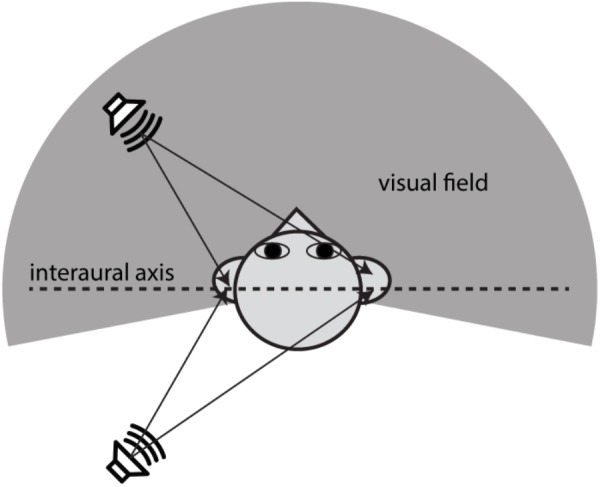
Illustration of the acoustic origin of the front–back confusion and the geometry difference between auditory and visual space. When the positions of two sound sources are mirror-symmetric along the interaural axis, the sound incidences from them will reach the ear canals with the same ITDs. This symmetry in binaural cue distribution is the cause of front–back confusions in sound localization. The auditory space embraces both frontal and rear fields, whereas the visual field is limited largely to the frontal field. This study addresses the question whether vision affects the front–back confusion in sound localization.